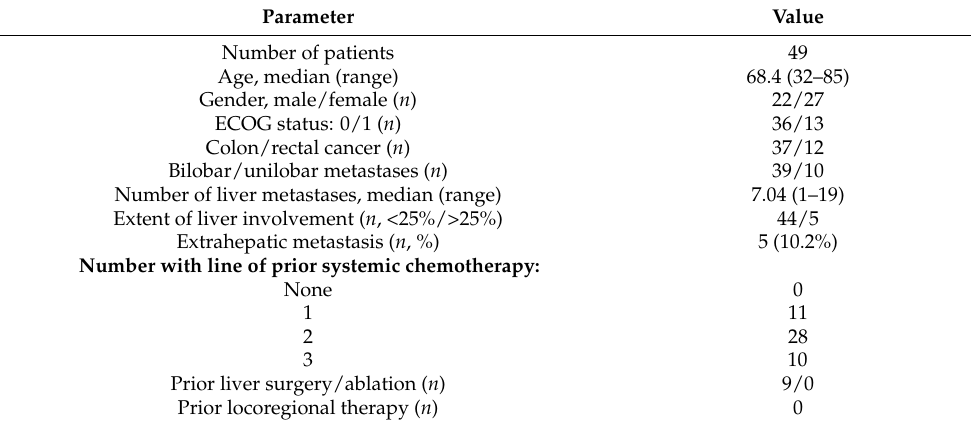
Table 1. Patient